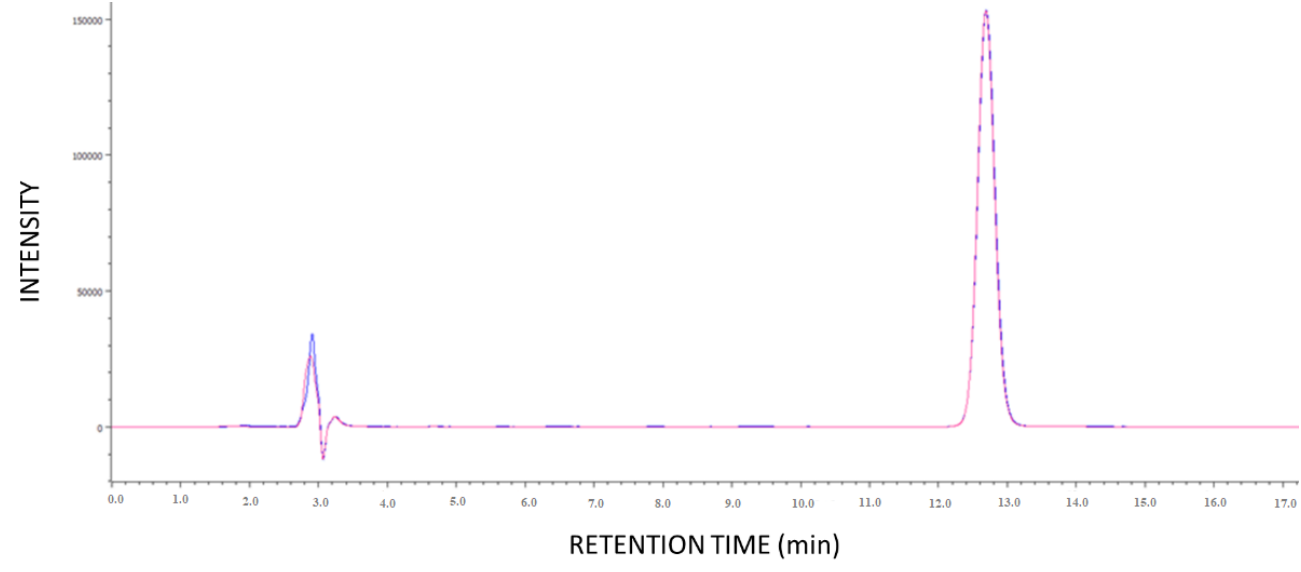
Figure 6. HPLC chromatograms of the melatonin loading solution before (blue line) and after steam heat sterilization (red line) ( n = 3).